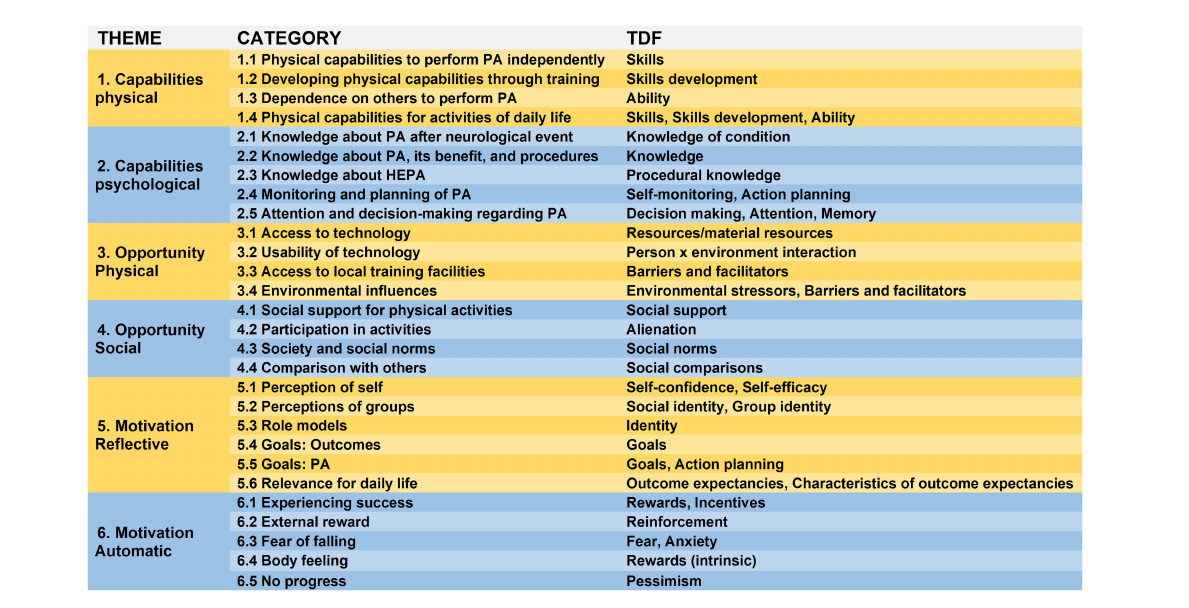
FIGURE1 The six themes and 28 categories from the thematic analysis of the interviews and the theoretical domain framework (TDF) constructs. HEPA, health enhancing physical activity; PA, physical activity; TDF, theoretical domain